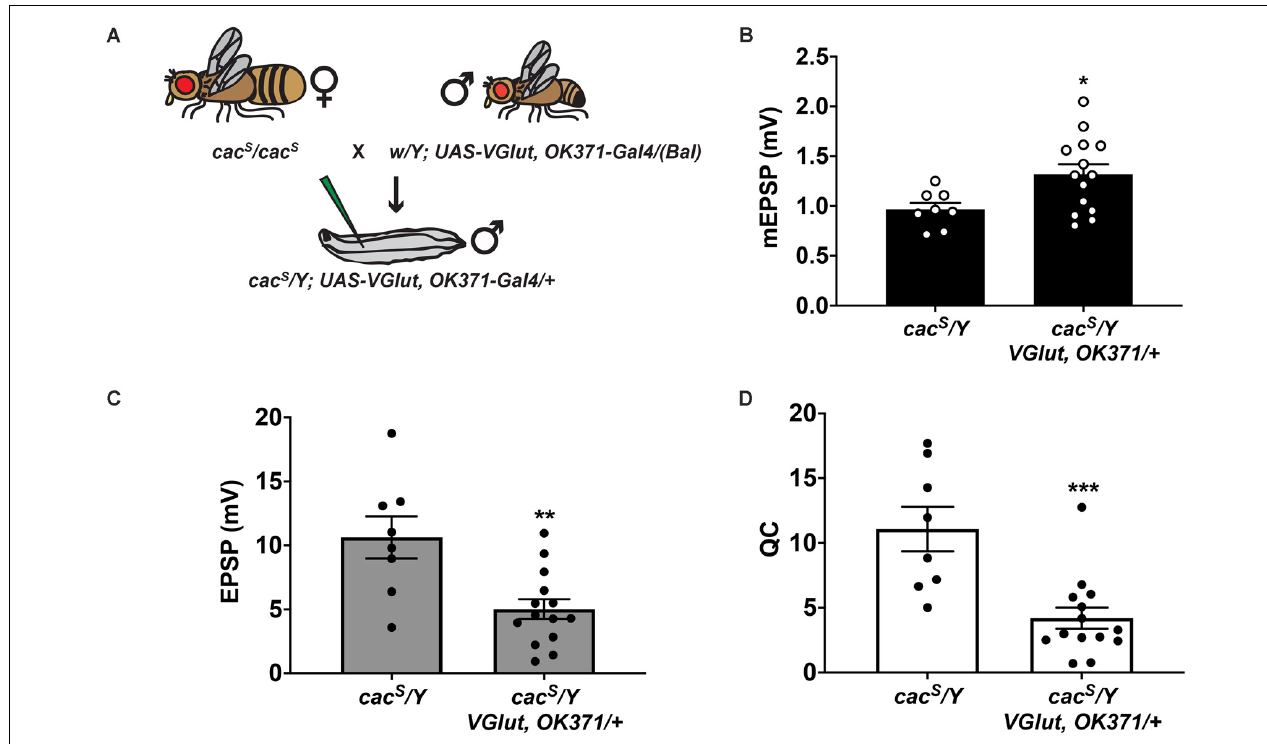
FIGURE 8 | Partial impairment of Ca V 2/Cacophony and PHD. (A) Crossing scheme for generating larvae for electrophysiological recording. Male larvae were hemizygous for the cac S hypomorphic mutation. Fly artwork reproduced from Brusich et al. (2015) under a Creative Commons Attribution License. (B) Raw data for mEPSPs. (C) Raw data for EPSPs. (D) Raw data for QC. For (B–D) , bars are averages and error bars are ± SEM. * p < 0.05, ** p < 0.01, and *** p < 0.001 by Student’s t -test comparing the control cac S dataset (no VGlut overexpression) vs. the experimental cac S dataset ( VGlut overexpression).